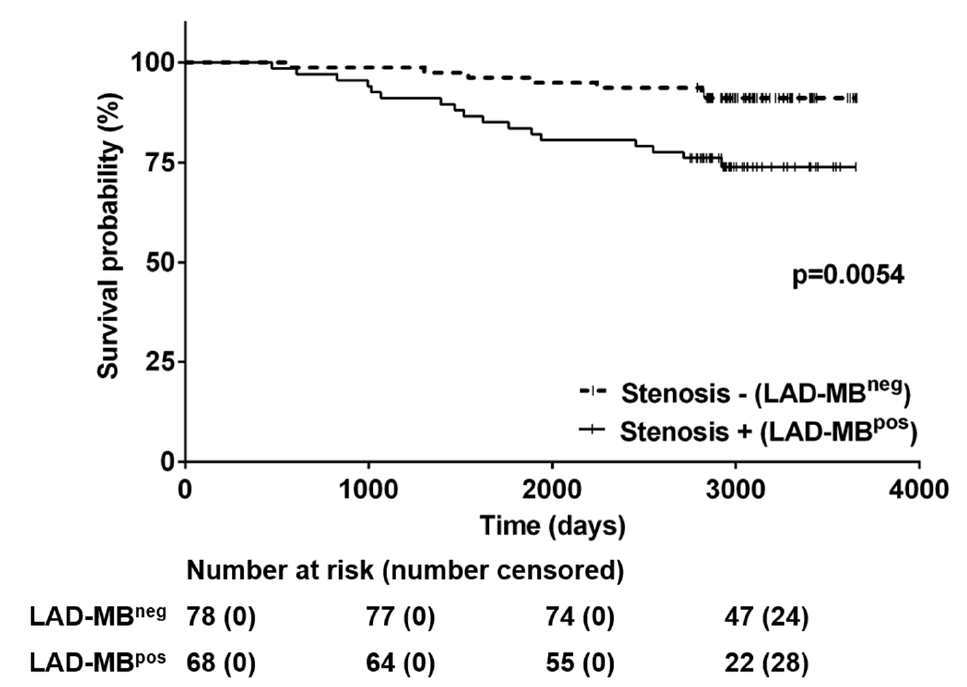
Figure 3. Kaplan–Meier curve of the long-term follow-up comparing LAD-MB pos (left anterior descendent myocardial bridge with another significant atherosclerotic coronary lesion) and LAD-MB neg (left anterior descendent myocardial bridge without another significant atherosclerotic coronary lesion) group. The LAD-MB pos group was associated with higher mortality.